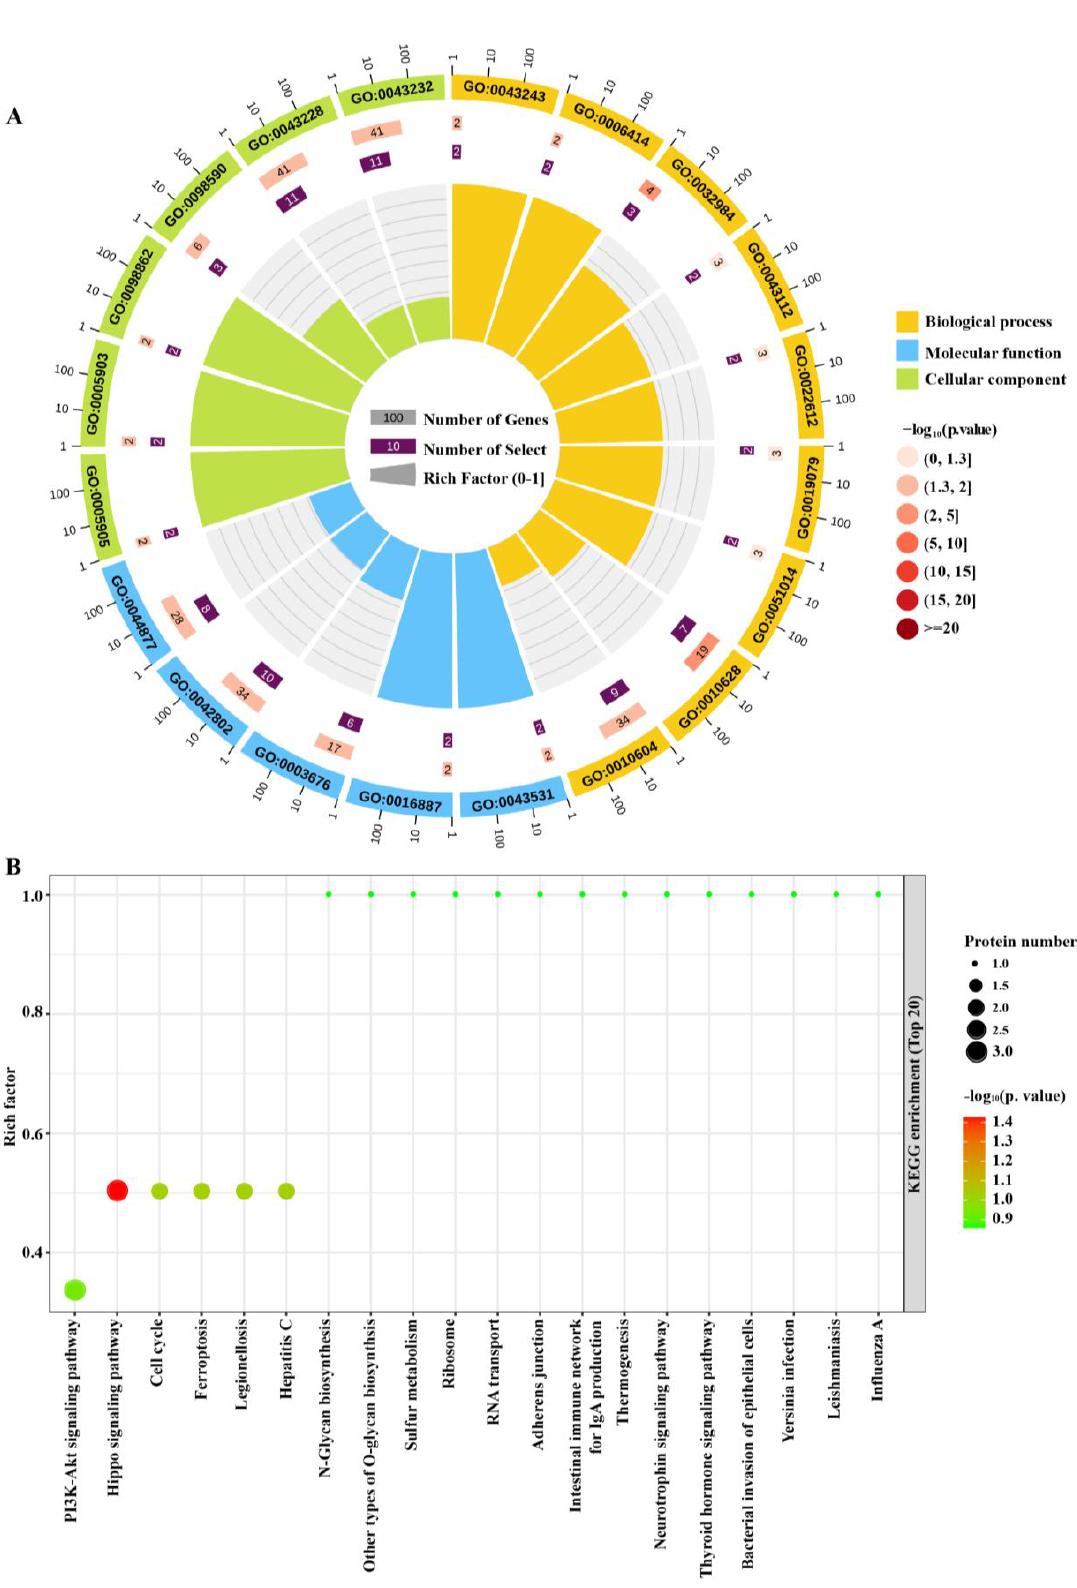
Figure 2. Bioinformatics analyses of the differentially expressed (DE) proteins. Serum proteome identified multiple dysregulated proteins in the rabbit CAS provocation model. ( A ) GO enrichment analysis of the 67 DE proteins. Proteins associated with biological processes (BP), molecular functions (MF), or cellular components (CC) are shown in orange, blue, or green, respectively. ( B ) KEGG analysis of the 67 DE